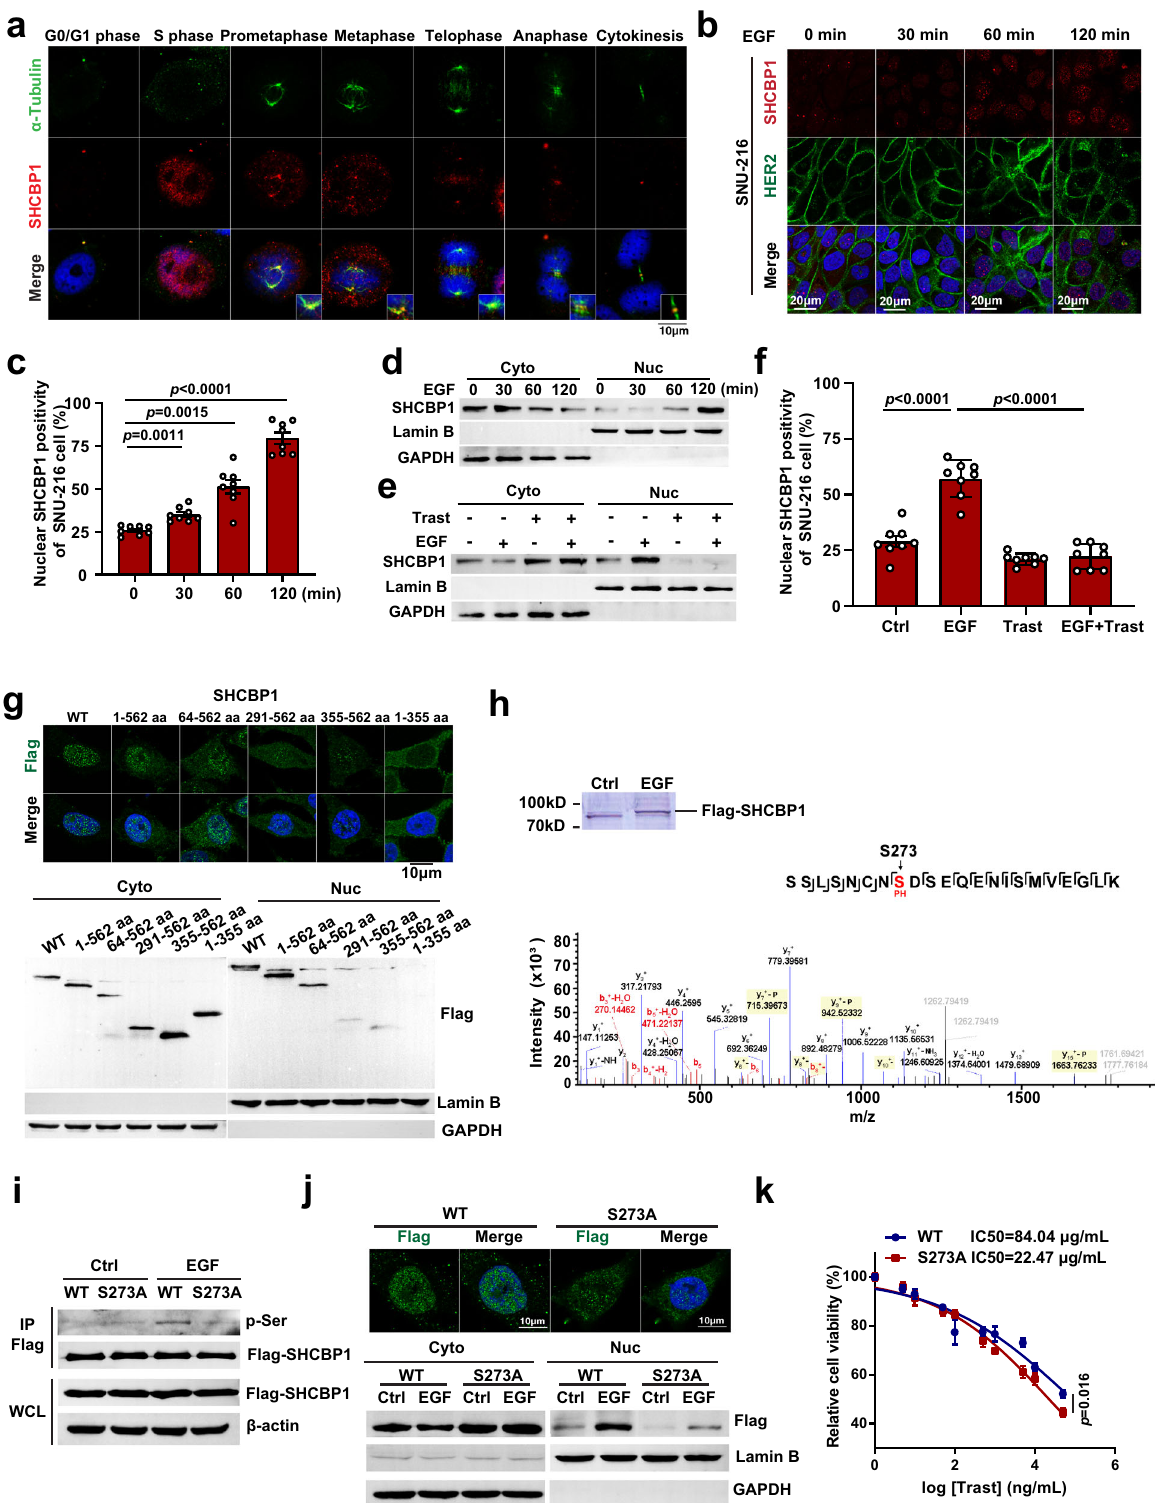
TFBG sensitizes gastric cancer to trastuzumab therapy by blocking SHCBP1 – PLK1 – MISP axis . To investigate whether combining trastuzumab with inhibitor TFBG might result in additive or synergistic effects on the growth of HER2-positive gastric cancer, we detected the effect of the trastuzumab – TFBG combination on tumor growth both in vitro and in vivo. Cell proliferation assays indicated that the addition